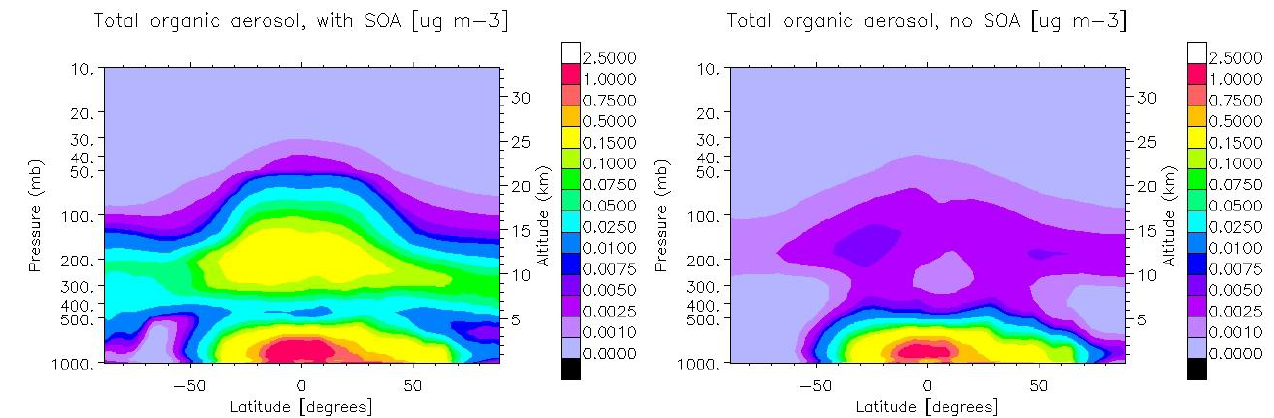
Figure 5. Annual zonal mean total particulate organic matter (POM) with SOA (left) and without SOA (right).